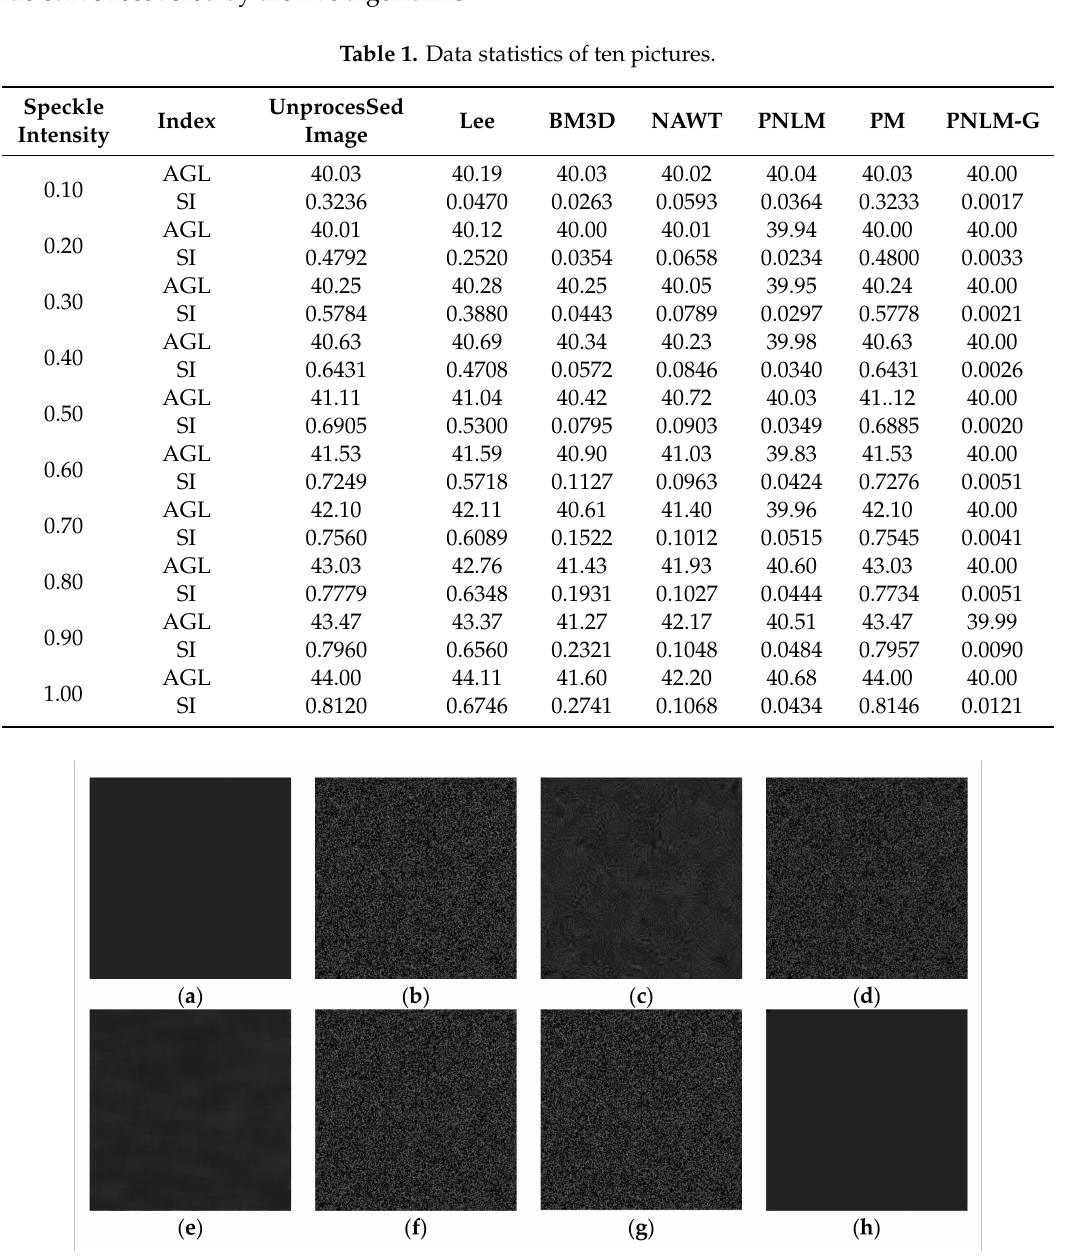
Figure 6. Six algorithm recovery e ff ects: ( a ) Original image; ( b ) after adding noise; ( c ) BM3D; ( d ) Lee; ( e ) PNLM; ( f ) NAWT; ( g ) PM; ( h )